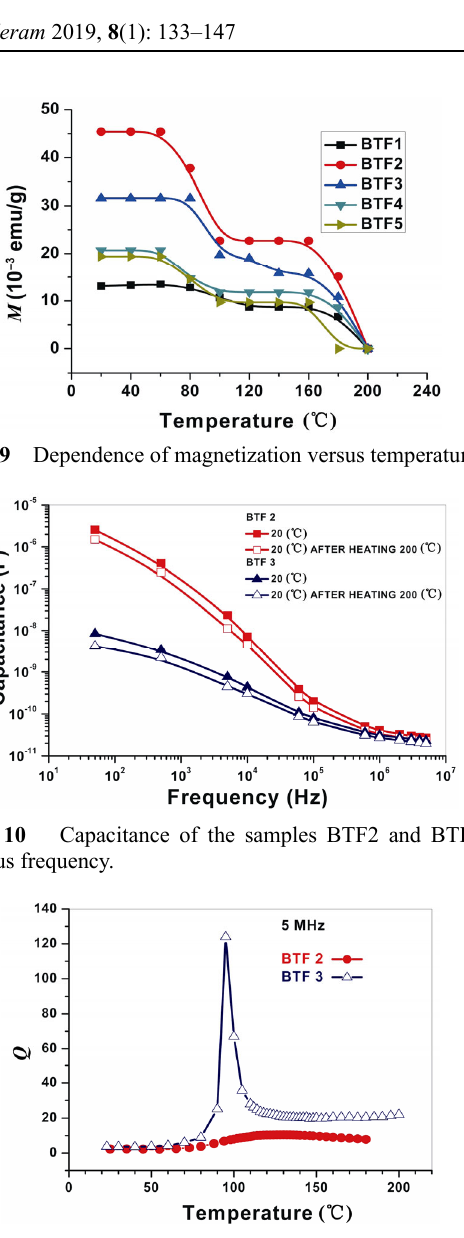
Fig. 11 Changes of Q factor with annealing